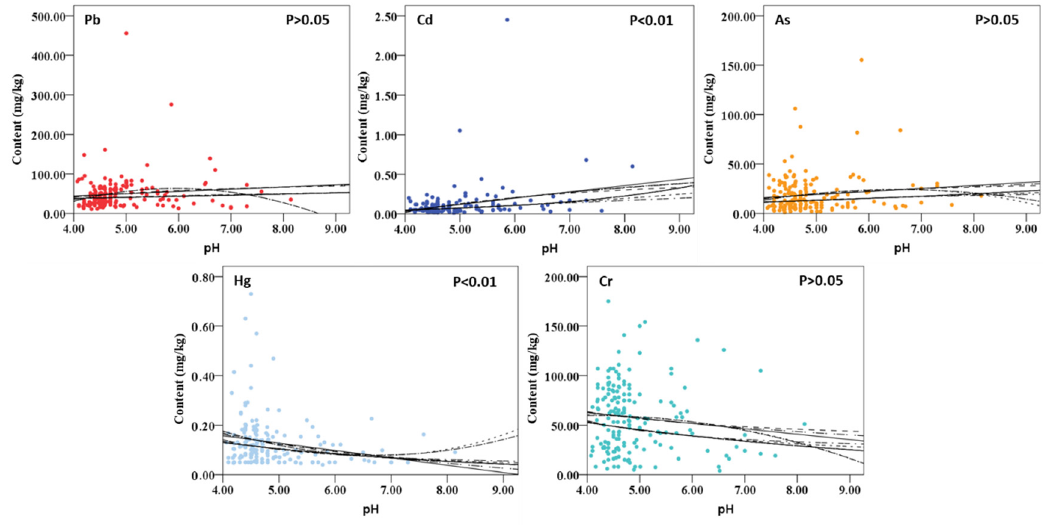
Figure 9. The relationship between heavy metals content and pH value of soil